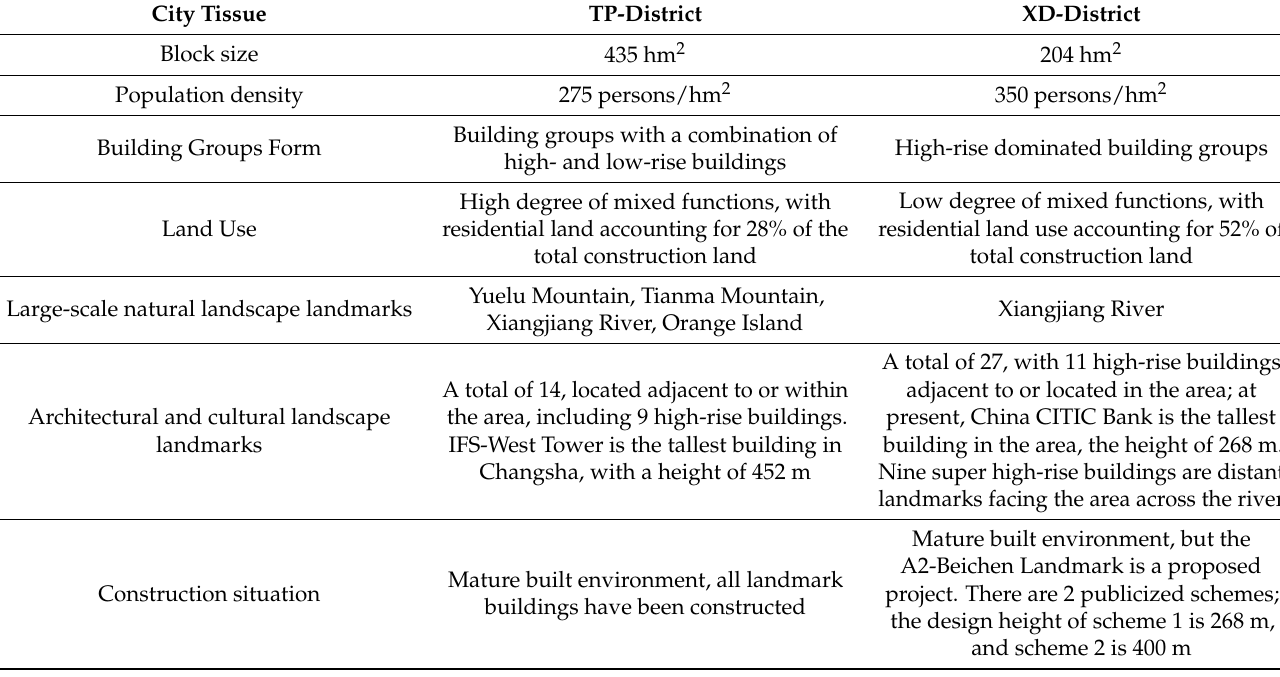
Table 2. Comparison of the spatial morphological characteristics of the two sample urban